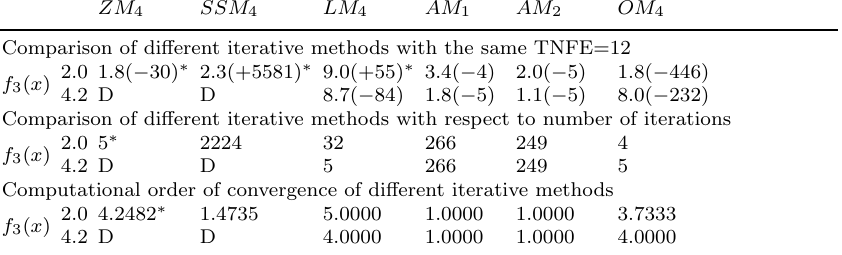
Comparison of different iterative methods with the same